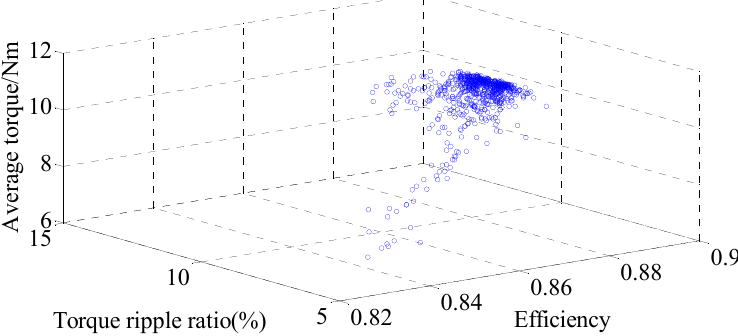
Figure 5. Three-objective Pareto results.